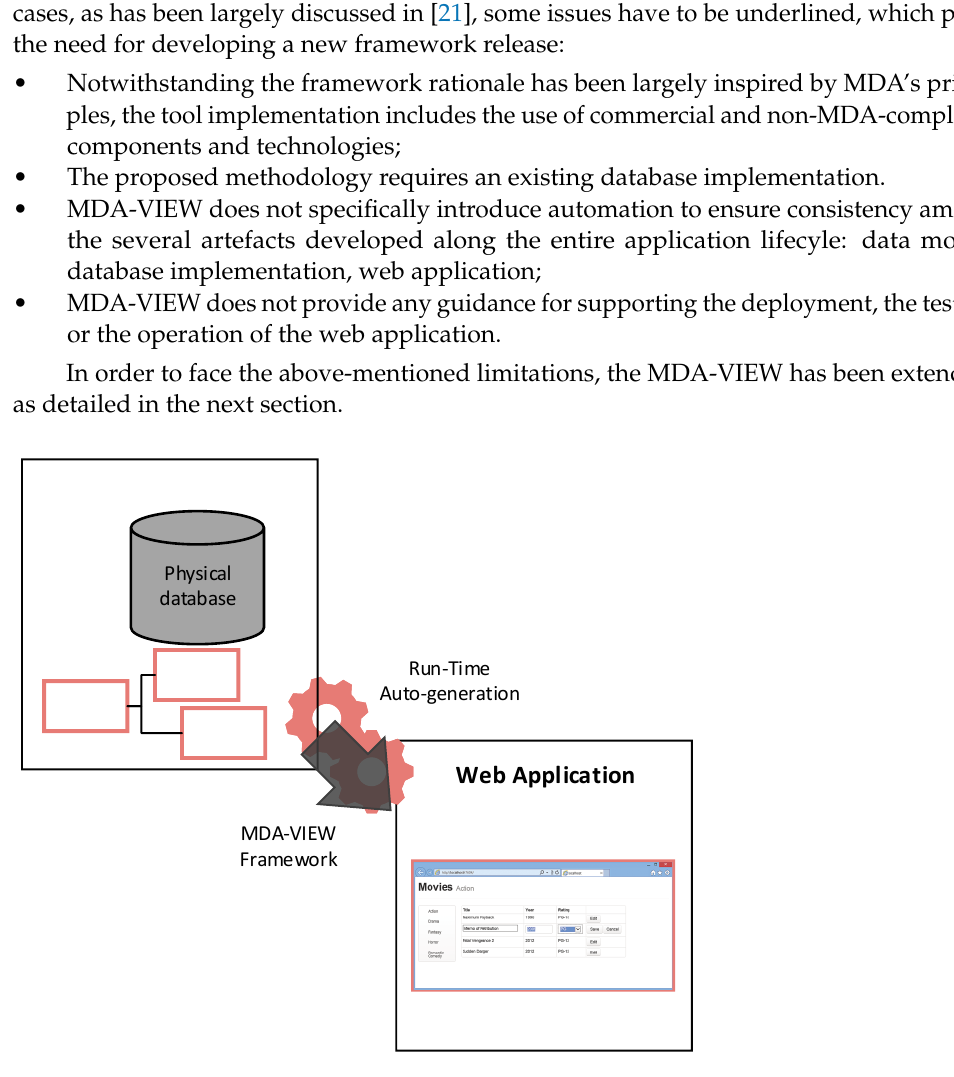
Figure 5. MDA-VIEW Development